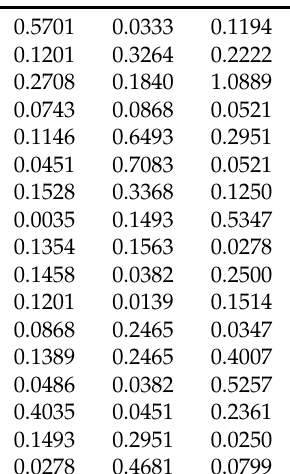
Table 9. Data of urinary tract infections in patients.